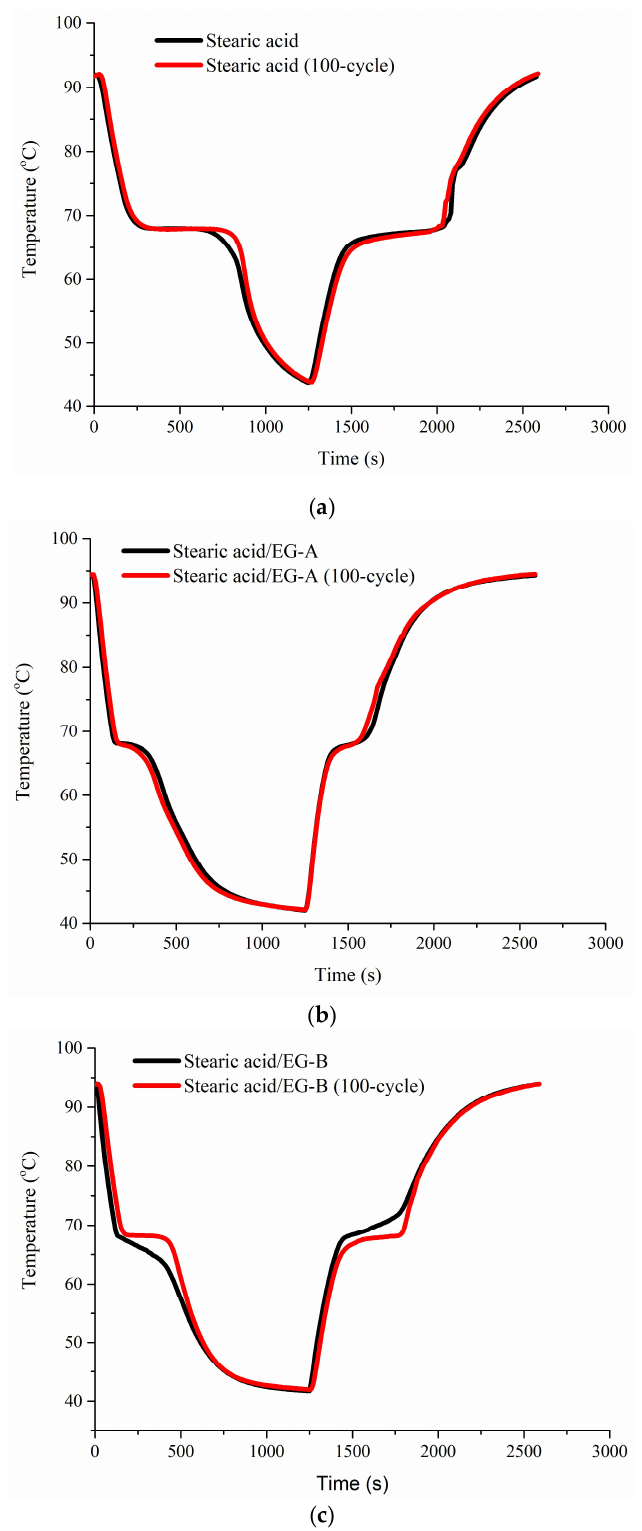
Figure 6. The thermal storage and release curves before and after 100 cycles: ( a ) Stearic acid, ( b ) stearic acid/EG-A, and ( c ) stearic acid/EG-B.